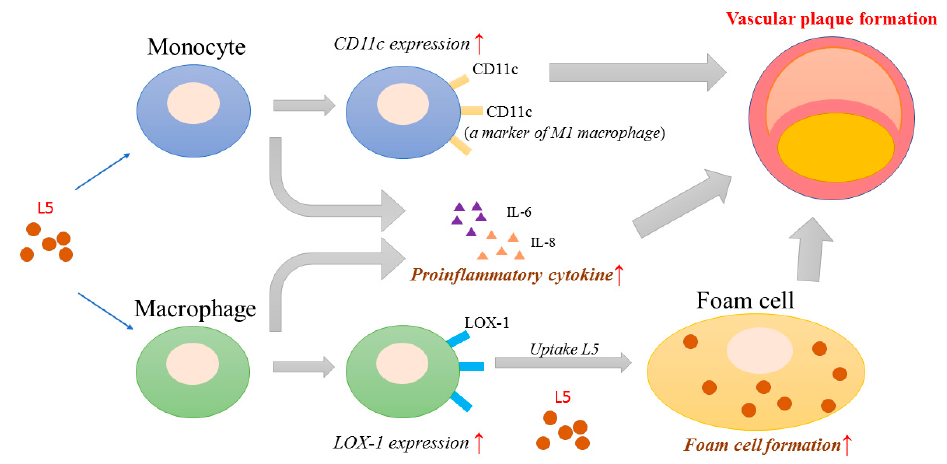
Figure 4. Proposed model for the potential role of L5 in RA-related atherogenesis. L5 induces the expression of CD11c, which is associated with vascular plaque formation [23,27] and is a marker for M1 macrophages that secrete proinflammatory cytokines [26]. L5 also upregulates the expression of inflammatory cytokines, interleukin (IL)-6 and IL-8, in both monocytes and macrophages. In addition, L5 induces LOX-1 expression and promotes foam cell formation by uptake of L5. The elevated levels of inflammatory cytokines and macrophage foam cell formation may contribute to vascular plaque formation in RA-related atherogenesis.